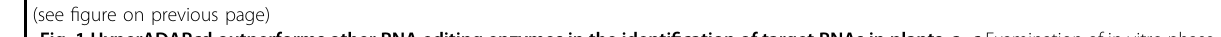
Fig. 1 HyperADARcd outperforms other RNA editing enzymes in the identi fi cation of target RNAs in plants. a – c Examination of in vitro phase separation behaviors of puri fi ed YFP-AtUBP1c in the presence of crowding agent PEG with or without 1 M NaCl by white light photograph ( a ) and optical density measurement at 600 nm (OD 600 nm ; b ) of turbidity changes and by confocal microscopy observation of droplet formation ( c ). Data in b are presented as means ± SD of OD 600 nm value in a ( n = 8). d , e In vivo FRAP of YFP-AtUBP1c condensates without ( − ETI; upper) or with ( + ETI; lower) the induction of ETI through transient expression in N. benthamiana . Arrowhead indicates the region of interest for FRAP ( d ). Data in e are presented as means ± SD for the time course of the recovery after photobleaching in d ( n = 6). Scale bar, 5 µm. f Schematic overview of RBP-directed adenosine deaminase (HyperADARcd and TadA) and cytidine deaminase (rAPOBEC1, PmCDA1, and AtCDA1) enzymes in conversion of nucleotide A to I (G) and C to U (T), respectively. g – m Identi fi cation of AtUBP1c target RNAs without ( − ETI) or with ( + ETI) ETI induction through transient expression of HyperADARcd or HyperADARcd-AtUBP1c in N. benthamiana . Non-treatment leaf serves as a control. g Cumulative frequency curve showing the RNV rate distribution patterns of non- fi ltered A>G RNVs. h The total number of fi ltered A>G RNVs (removing RNVs with rate > 90%). i Nucleotide context surrounding A>G RNVs in samples expressing HyperADARcd-AtUBP1c. x -axis, the relative distance from the editing sites (position 0). j Venn diagram showing constitutive and speci fi c RNVs (left) and genes (right) of HyperADARcd-AtUBP1c without ( − ETI) or with ( + ETI) ETI induction. k 3D-density plot showing RNA levels of HyperADARcd-AtUBP1c + ETI target genes (13373 + 2360) in both conditions. Three red dashed lines from left to right indicate Z_log 2 RSfc (RNA-seq fold change) = 1.5, 0, and − 1.5, respectively. Only genes with RPKM ≥ 1 in both conditions are shown as a background layer of gray dots. r 1/ r 2, Pearson correlation coef fi cient for the total transcriptome and ETI target genes, respectively. l Schematic overview of 1D and 3D modes of RBP-directed HyperADARcd editing by linear and structurally spatial proximity, respectively. m AtUBP1c fusions with TadA, rAPOBEC1, PmCDA1, and AtCDA1 were used to detect target RNAs during ETI induction. Data are shown as percentages of the 12-type RNVs in each sample. Total RNV numbers are indicated above. The expected RNV type for each enzyme is checked. n Identi fi cation of OsUBP1c target RNAs in transgenic rice using HyperADARcd. Non-transgenic parent ZH11 and transgene-negative progeny are used as controls. Data are shown as fi ltered A>G RNV numbers. Each RNA-seq sample was combined from at least 9 individual plants. RNV numbers from different sample libraries were normalized using scale factors de fi ned in Supplementary Fig.